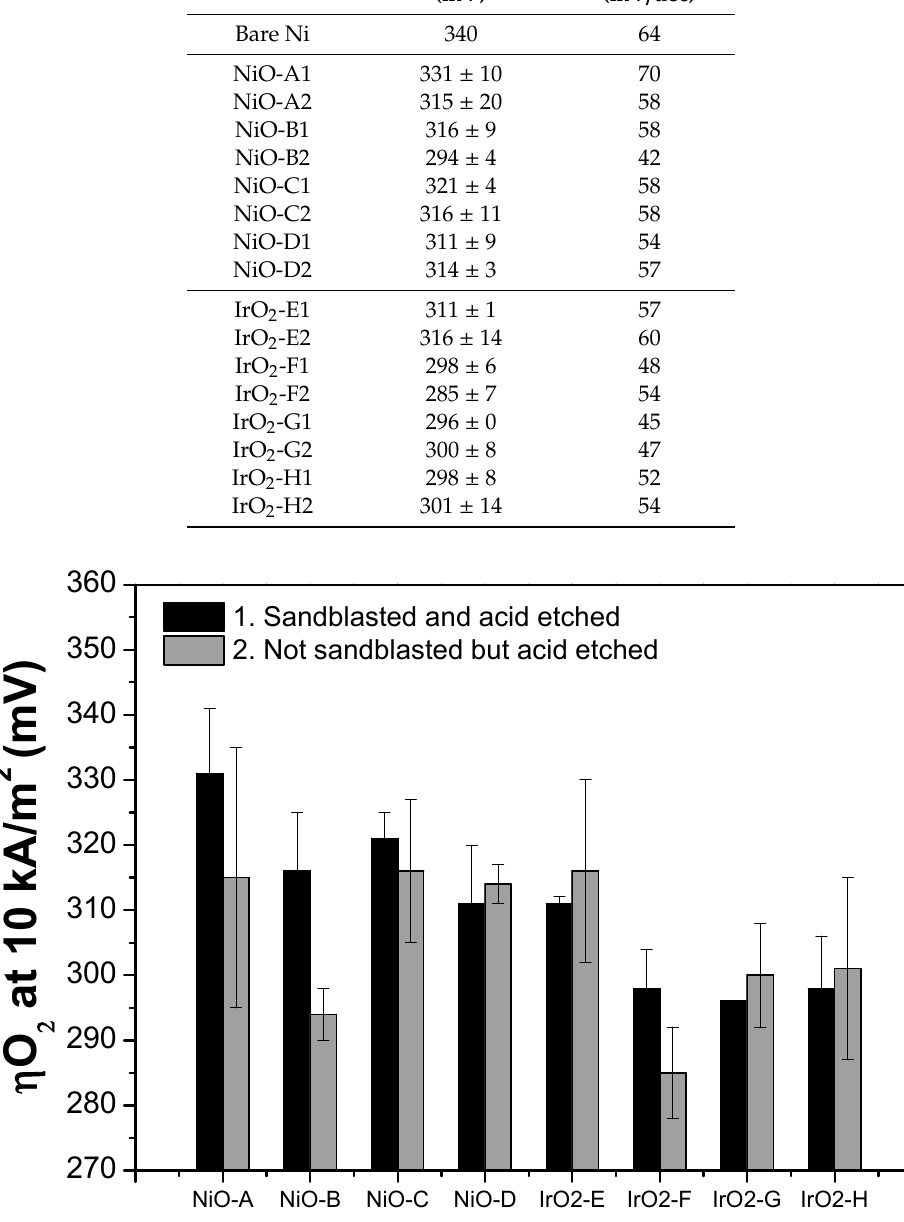
Figure 7. Oxygen overpotential values (at 10 kA / m 2 ) of the thin film electrodes. Left—sandblasted and acid etched; Right—not sandblasted but the acid etched Ni substrate. Table 4. Summary of the OER catalytic activity ( η O 2 at 10 kA/m 2 and Tafel slope) of the NiO and IrO 2 thin films.